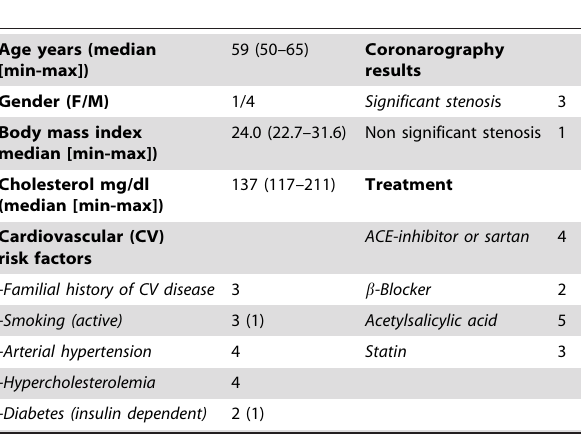
Table 3. Characteristics of cardiovascular patients (n=